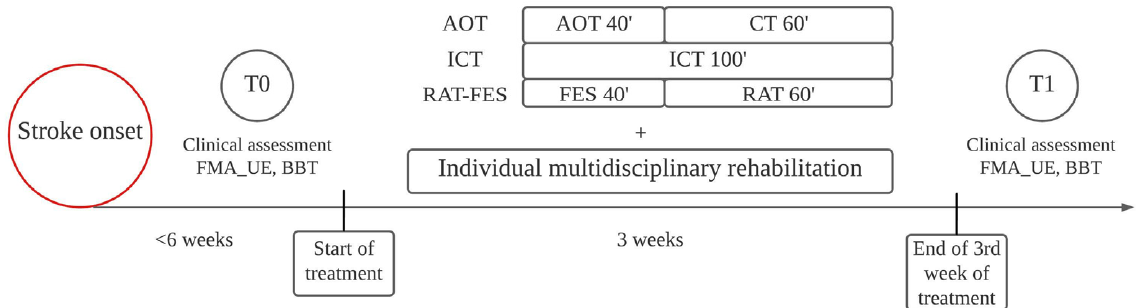
Figure 1. Timeline of the study. Patients were clinically evaluated and started treatments within six weeks of stroke onset. T0 marks the initial assessment before the beginning of treatments. T1 marks the clinical assessment after three weeks of treatment. As well as AOT, ICT, and RAT-FES, each patient received individual rehabilitation based on personal needs.